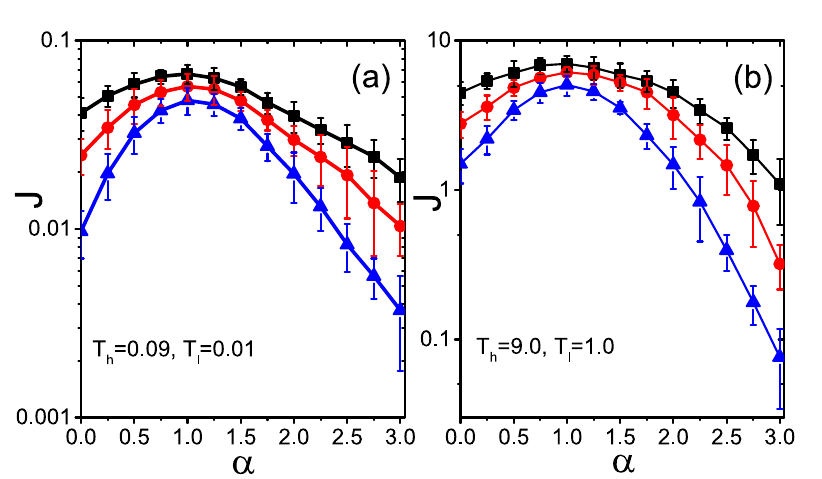
Figure 3. Influence of the controlling parameter α and the temperature of thermostats on the total flux J , with averaging over 50 realizations and randomly chosen source nodes. ( a ) For the case of T h = 0.09 and T l = 0.01 , J versus α for N = 300 , � k � = 4 and different p , where the “squares”, “circles” and “triangles” represent the results for the networks with p = 1, 0.5 and 0, respectively. ( b ) For the case of T h = 9.0 and T l = 1.0 , J versus α for N = 300 , � k � = 4 and different p , where the “squares”, “circles” and “triangles” represent the results for the networks with p = 1, 0.5 and 0,